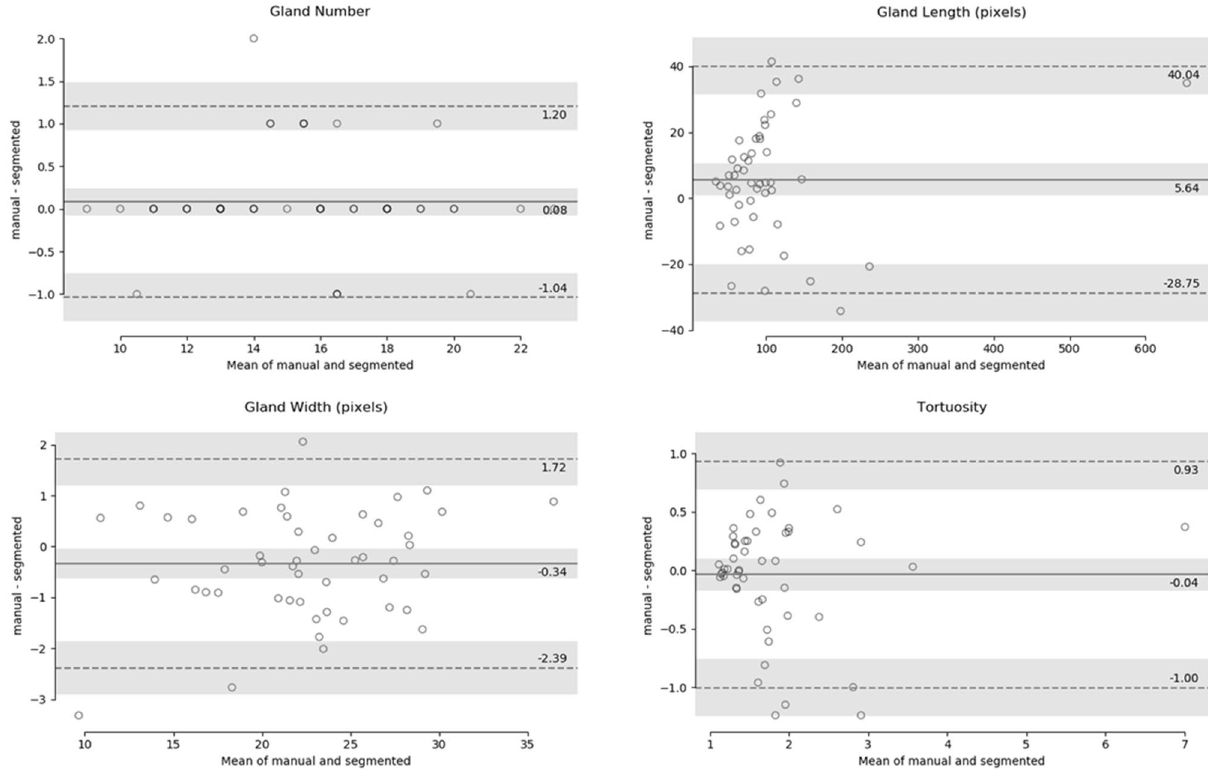
Figure 7. Bland–Altman plots of MGs number, length, width, and tortuosity between ground truth and deep learning segmentation for lower eyelid. The middle solid line indicates the mean value, the two dotted lines indicate the limit of agreement (± 1.96 SD), and the gray bar indicates the confidence interval of 95%.